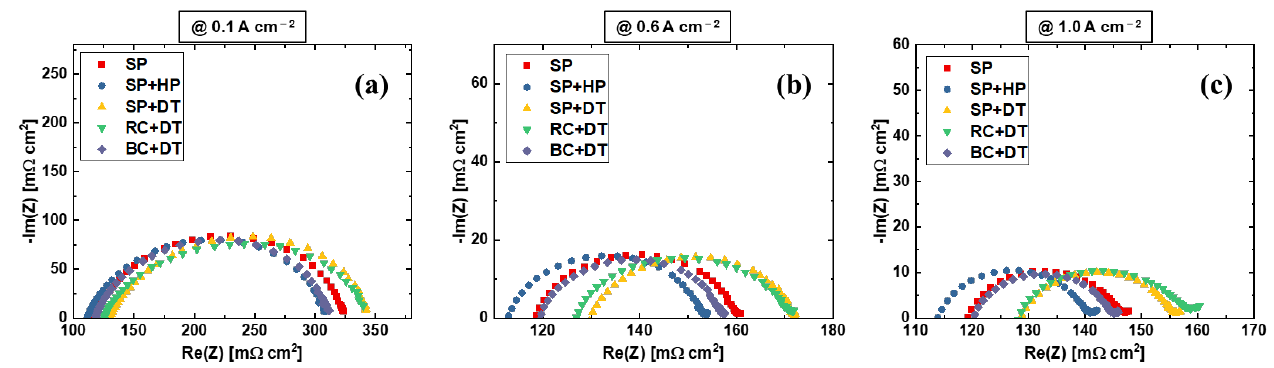
Figure 5. EIS comparison at ( a ) 0.1 A cm −2 , ( b ) 0.6 A cm −2 , and ( c ) 1.0 A cm −2 for various anode electrodes.